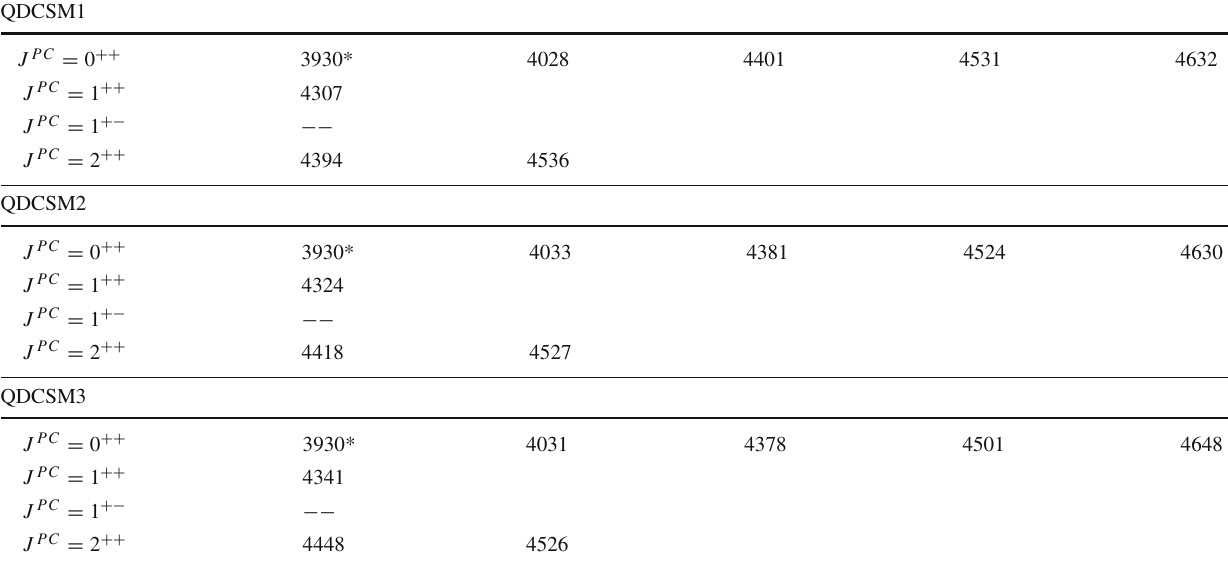
Table 8 The energies (in MeV) of the resonance states for the c ¯ cs ¯ s system